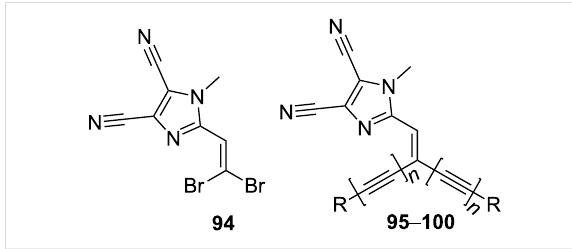
Figure 18: Dibromoolefin 94 and branched chromophores 95 – 100 [112,113].